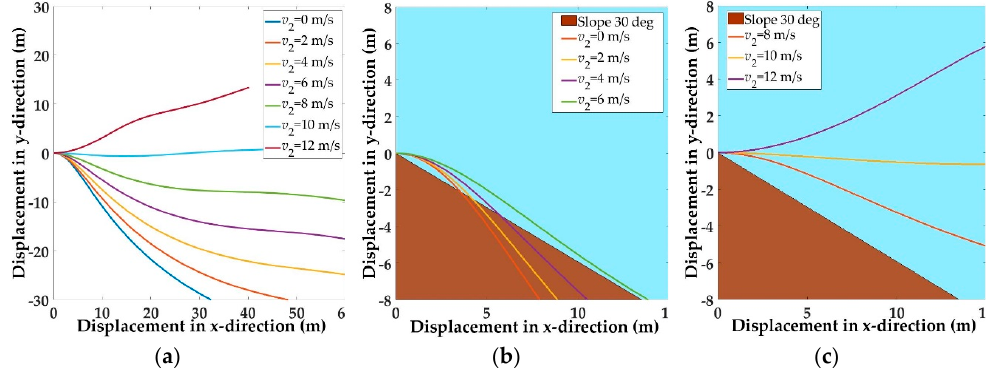
Figure 3. Trajectories of Anchiornis running at a speed of 5 m/s and 𝜽 = 30°: ( a ) 𝒗 𝟐 changes from 0 to 12 m/s; ( b ) 𝒗 𝟐 changes from 0 to 6 m/s; ( c ) 𝒗 𝟐 changed from 8 to 12 m/s.